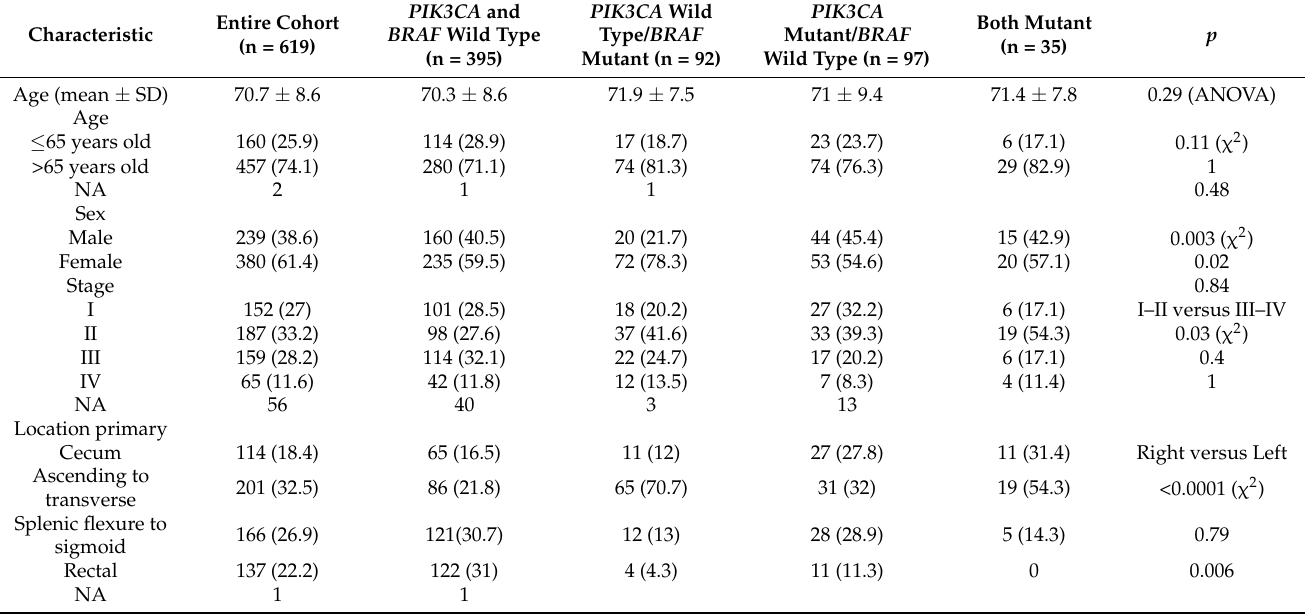
Table 2. Characteristics of colorectal cancers with BRAF and PIK3CA mutations in the DFCI cohort. NA: not available. Right cancers include cecum to transverse column and left cancers include those located from the splenic flexure to rectum. The p values presented in the last column refer to Fisher’s exact test except if stated otherwise. For each categorical characteristic, three comparisons are presented. The first includes all four groups (group with both PIK3CA and BRAF wild type, group with PIK3CA wild type and BRAF mutant, group with PIK3CA mutant and BRAF wild type, and group with both PIK3CA and BRAF mutant), the second comparison is between double mutant cancers and cancers with BRAF mutations and wild type PIK3CA . The third comparison is between double mutant cancers and cancers with PIK3CA mutated and BRAF wild type. For cancer stage comparisons in the four mutation groups, early stages (I and II) and advanced stages (III and IV) were grouped together in the statistical analysis. For the primary tumor location comparisons in the four groups, right colon cancers (cecum and ascending to transverse) and left colon cancers (splenic flexure to sigmoid and rectal) were grouped together in the statistical analysis. The comparisons of various characteristics of interest involving all four mutation groups were performed with the χ 2 test. Comparisons involving two groups were performed with the Fisher’s exact test when the characteristic of interest had 2 categories and with the χ 2 test when the characteristic of interest had more than 2